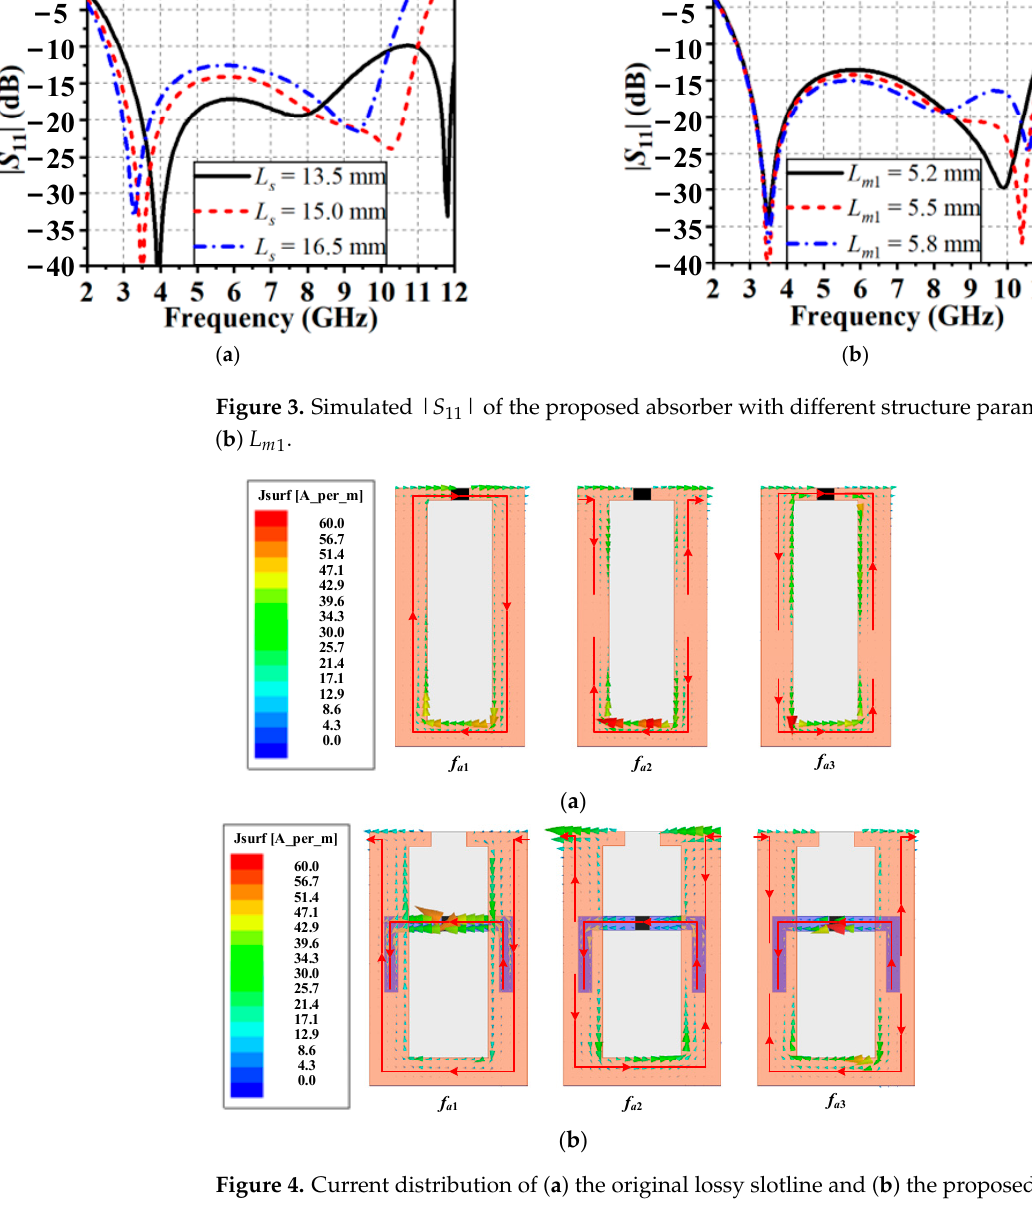
Figure 4. Current distribution of ( a ) the original lossy slotline and ( b ) the proposed 3D absorber.